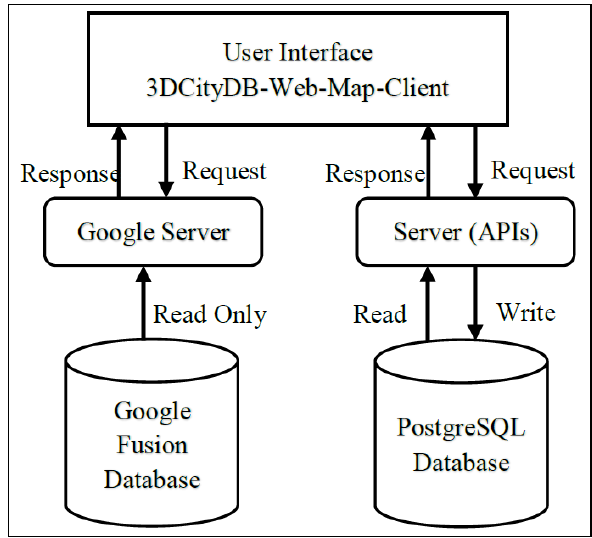
Figure 8. REST APIs server architecture, on the right, compared to the existing one, based on Google services, on the left In this way, the user is able to control and manage the thematic data layers by using the 3DCityDB-Webmap-Client as usual, either as layers linked with a Google Fusion table URLs or with the REST APIs server URL. If the user clicks on a city object that has a thematic data URL of a Google Fusion table, then the standard functionalities are provided (read-only access). If the user clicks on a city object with thematic data URL of a REST APIs server then the user can also update the city object